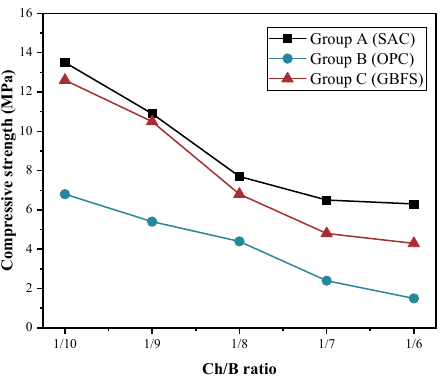
Figure 4. Compressive strength of the different series at 28 d.